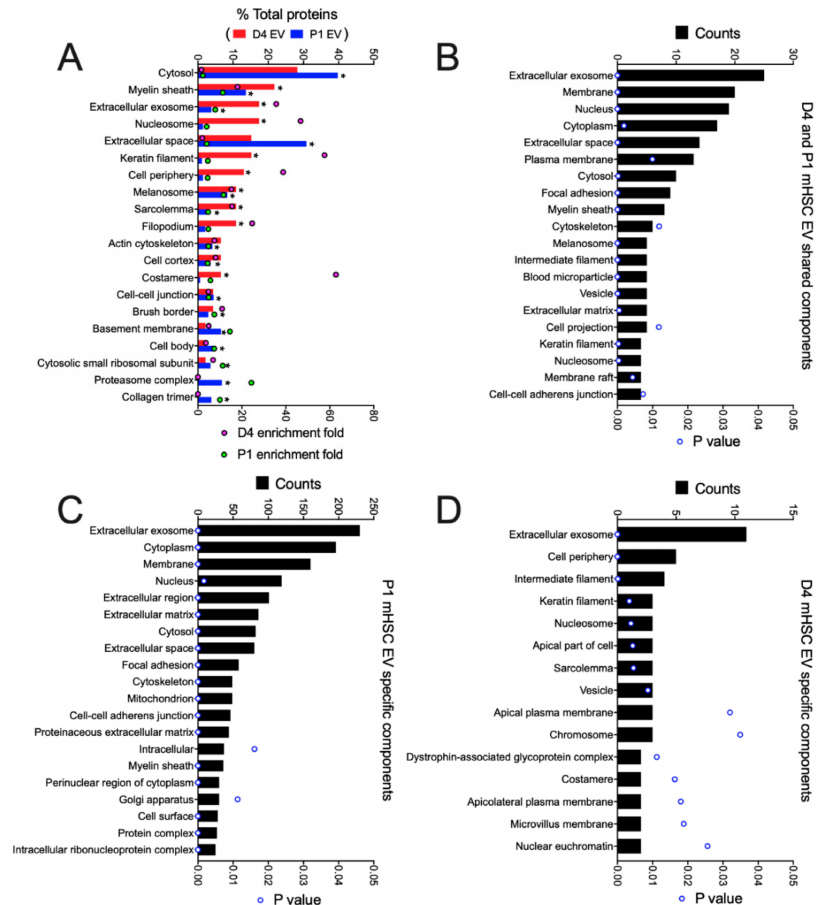
Figure 5. Cellular component analysis of proteins in EVs from D4 and / or P1 mHSC. GO analysis was performed using the Funrich database to identify EV proteins with significant enrichment versus the Uniprot database. The figure shows the 20 most highly ranked cellular components for proteins that were ( A ) in the entire mHSC EV proteome from D4 cells compared to those from P1 cells; ( B ) shared between EVs from D4 and P1 mHSC; ( C ) specific to P1 mHSC EVs. ( D ) Components specific to D4 mHSC EVs. Only cellular components with significant enrichment (* p < 0.05) are